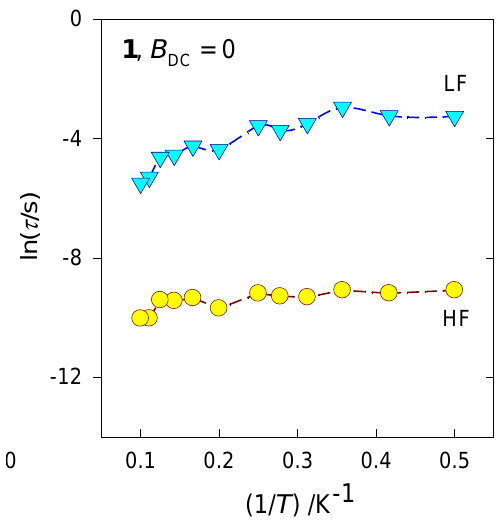
Figure 8. Arrhenius like plot of ln τ vs . T − 1 for 1 .